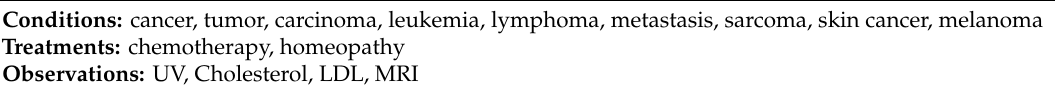
Table 1. Keywords for the Twitter stream for Public Health